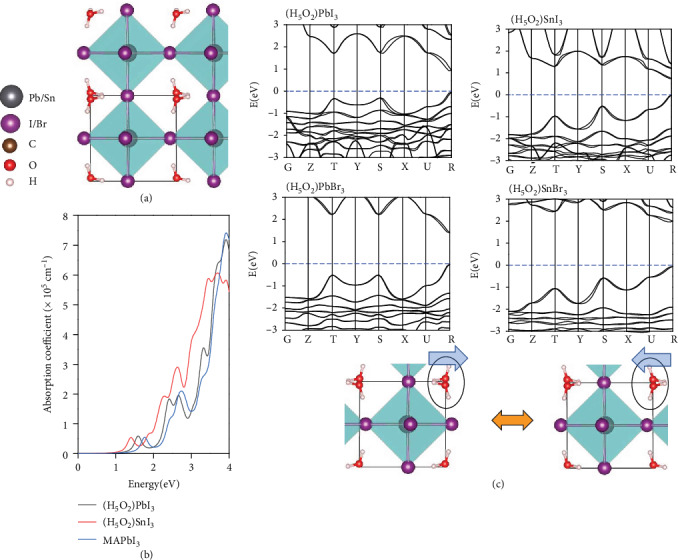
(a) Computed band structures of the cubic phase (H5O2)PbI3, (H5O2)SnI3, (H5O2)PbBr3, and (H5O2)SnBr3. (b) Computed optical absorption spectra of (H5O2)PbI3 and (H5O2)SnI3. (c) Ferroelectric switching of (H5O2)SnI3. The blue arrows denote the polarization direction of cations and the whole crystal.